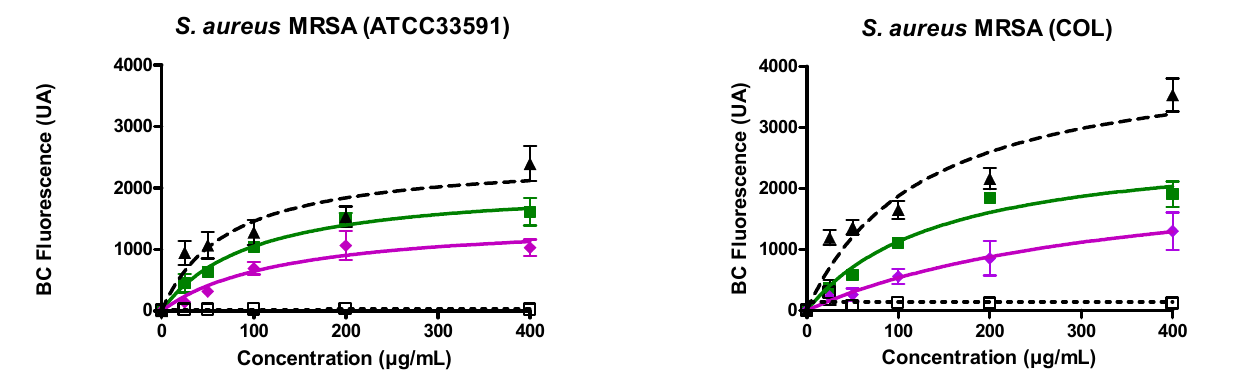
Figure 1. BODIPY TM -TR-cadaverine (BC) displacement from its binding to LTA (Lipoteichoic acids) of S. aureus (MRSA (ATCC 33591 and COL)) induced by increasing concentrations of alexidine (black triangles, dashed line ▲ ), UA (Ursolic acid; green squares, ■) , OA (Oleanolic acid; pink diamonds, ♦) , neamine (black open squares, dotted line □ ). The data represent the mean ± SEM of three independent experiments.